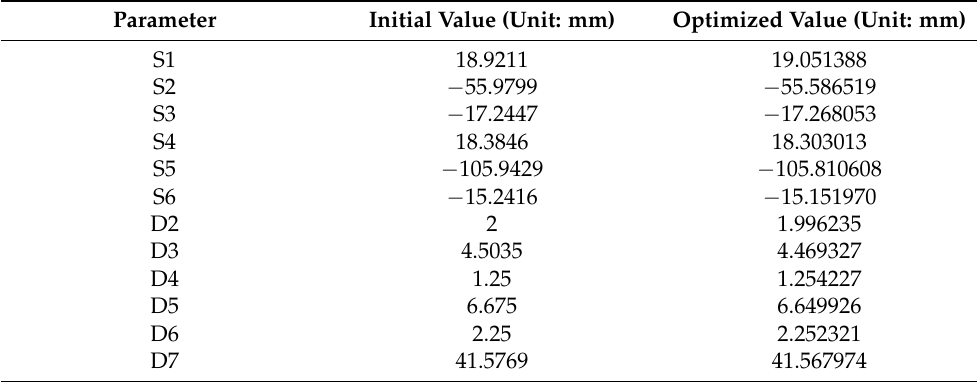
Table 9. Comparison of design parameters before and after optimization (Case 2).